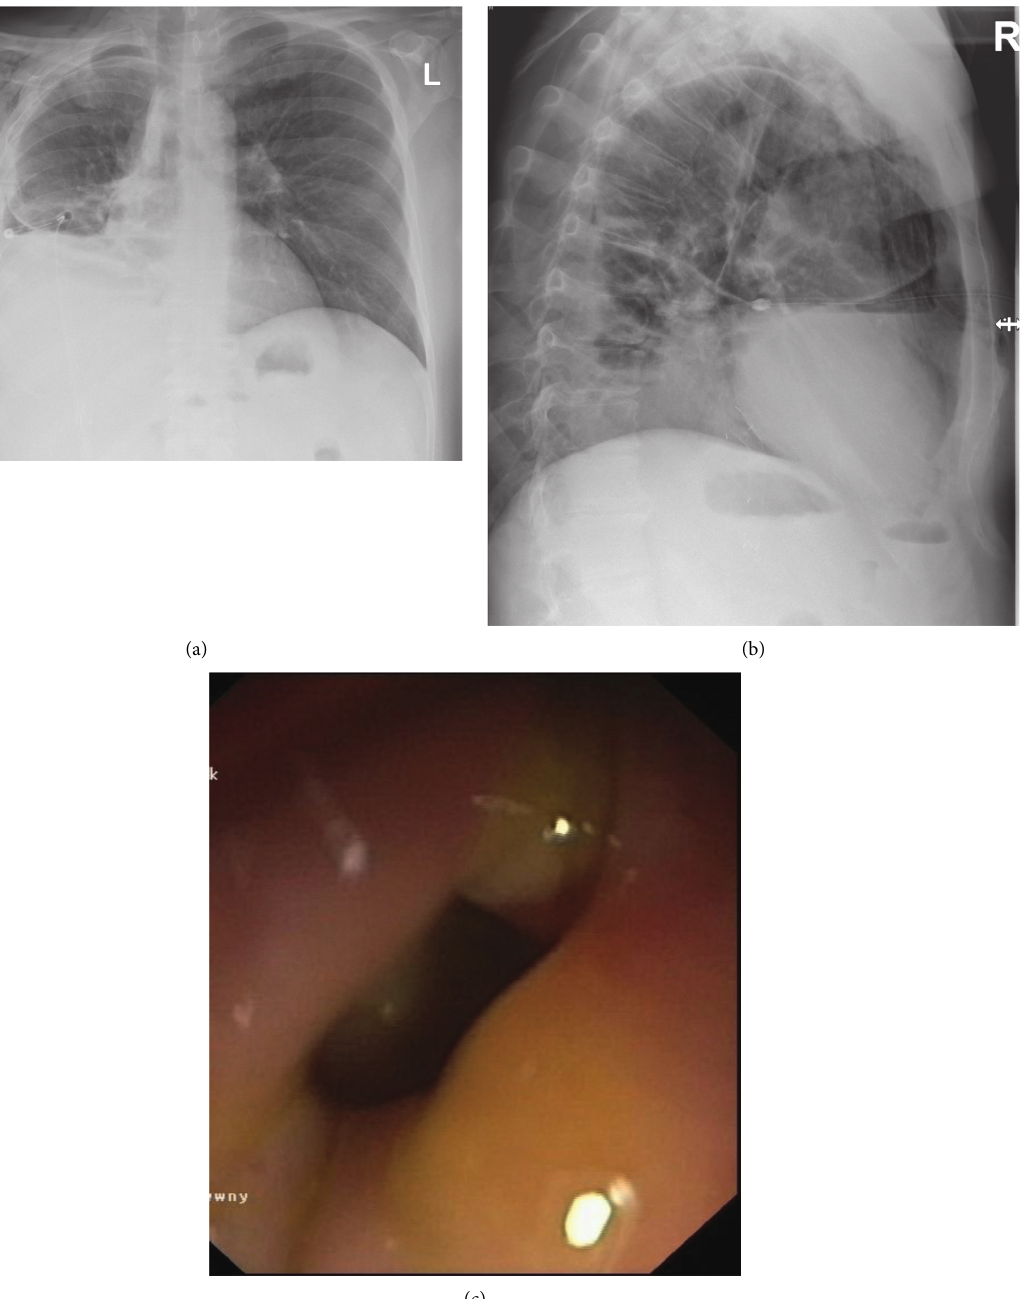
Figure 2: (a–c) Late complication of endoscopic treatment in the form of biliopleural fistula. Right pleural cavity